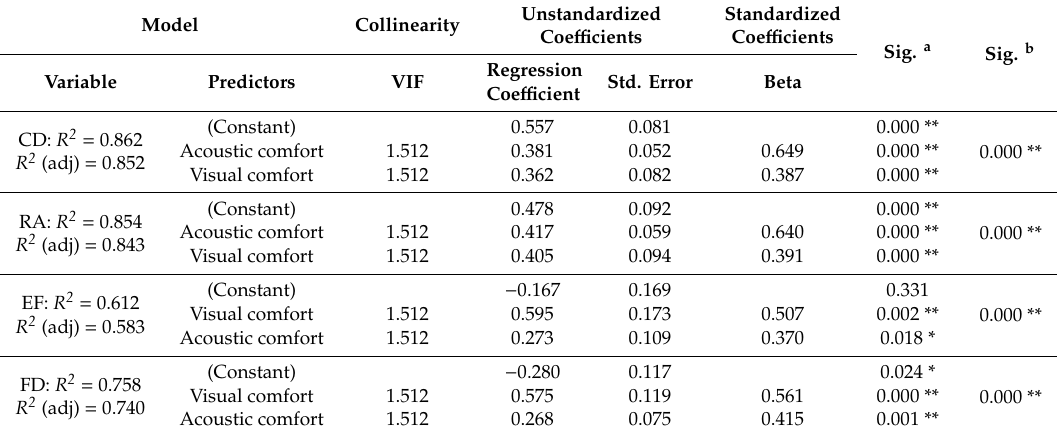
Table 4. Stepwise regression model for audio-visual experiences and psychological responses in Music Park.